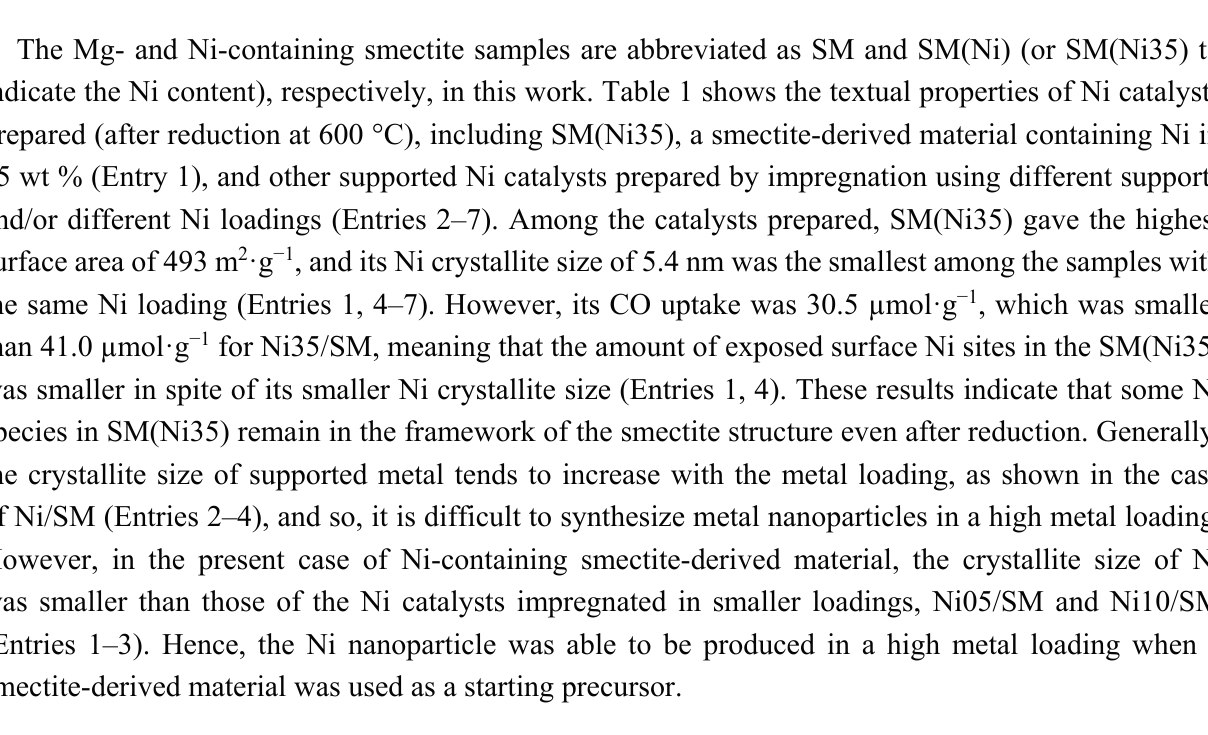
Table 1. Textual properties of the different Ni catalysts